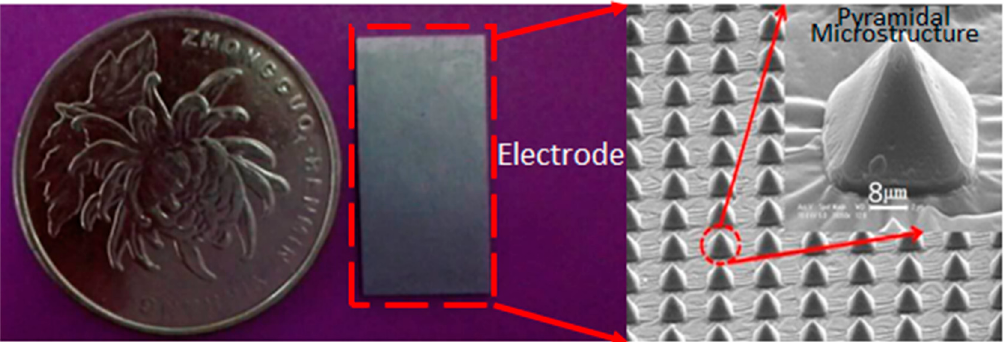
Figure 2. The SEM photographs of pyramidal microstructure arrays.